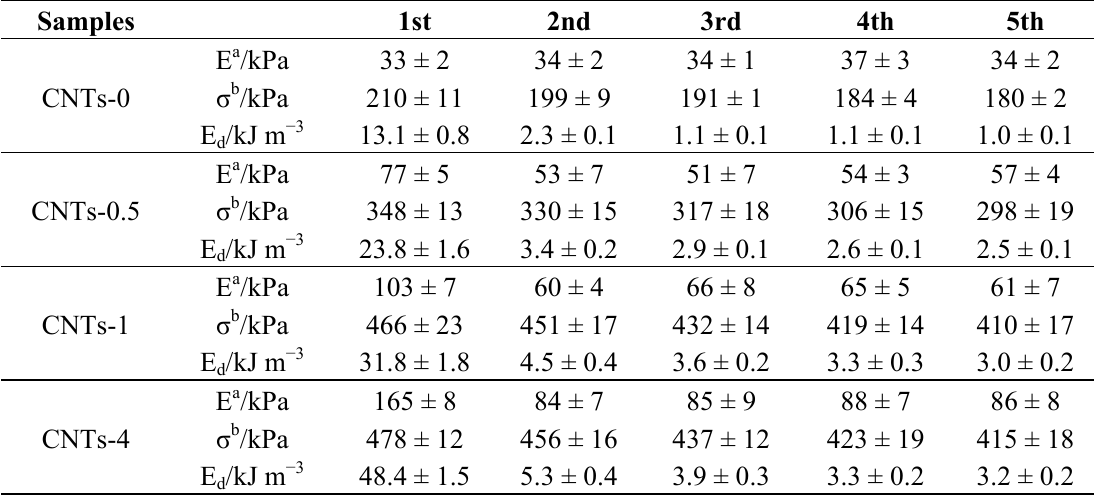
Table 3. Initial modulus, compressive stress, and hysteresis loss of five consecutive compressive loading-unloading cycles were given for the neat and nanocomposite.